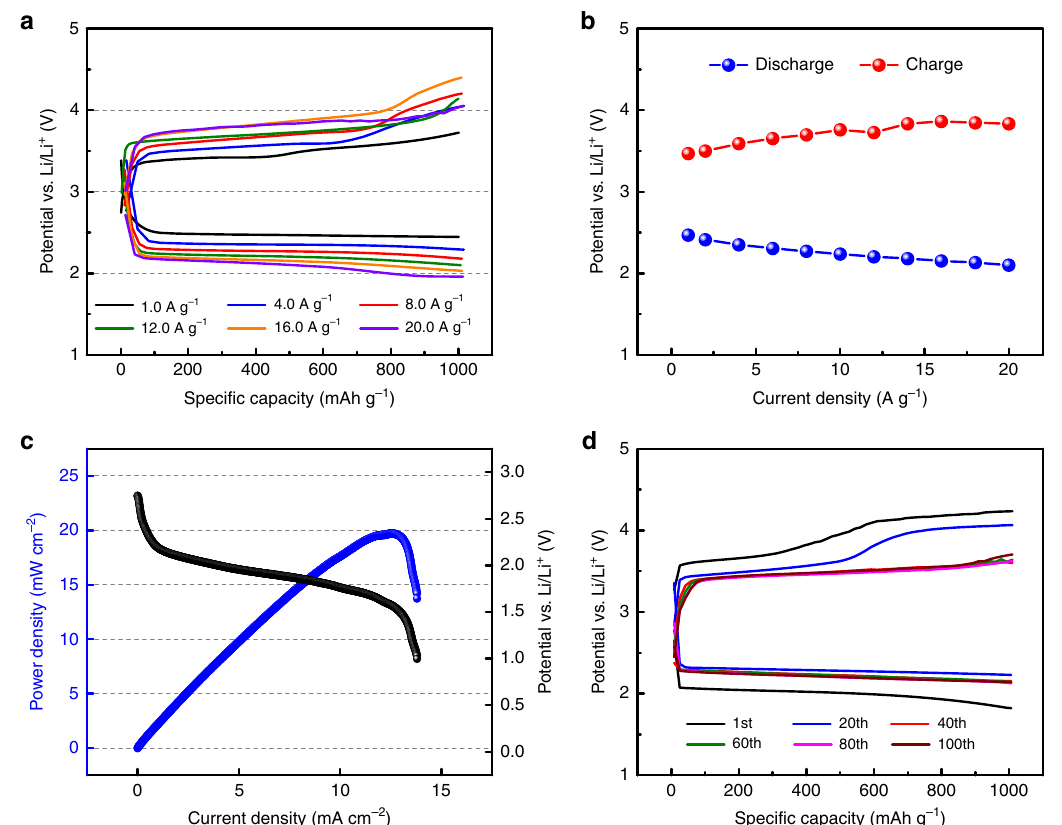
Fig. 4 Electrochemical performance of Li – CO 2 cell with quinary-molten salt electrolyte. a Galvanostatic discharge – charge pro fi les of the Li – CO 2 battery with quinary-molten salt electrolyte at different current densities from 1.0 to 20.0 A g − 1 at 150 °C. b Plots of discharge – charge overpotential measured at 500 mAh g − 1 as a function of current density. c Plots of operating voltage and power density versus current density of the Li – CO 2 battery at 150 °C with scan rate of 0.01 mA s − 1 . d Galvanostatic discharge – charge pro fi les of a Li – CO 2 cell with 2.0 A g − 1 current density over up to 100